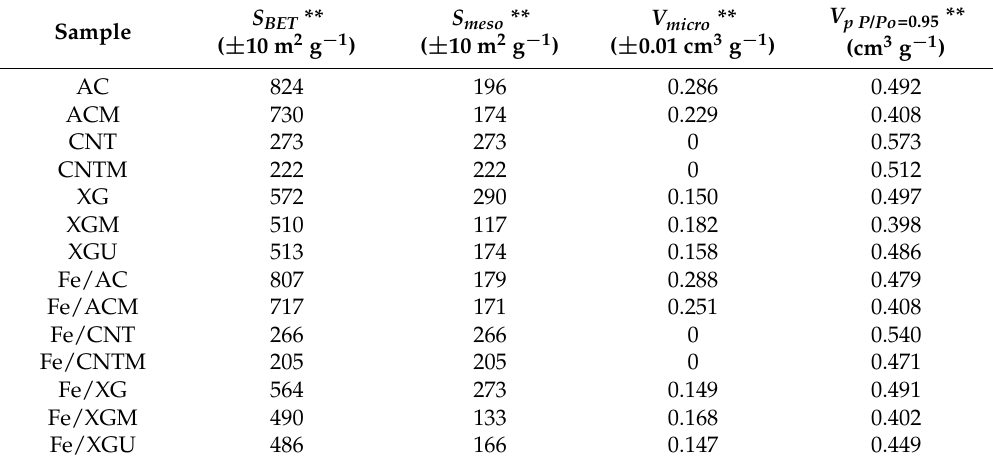
Table 1. Textural properties of the carbon-based materials